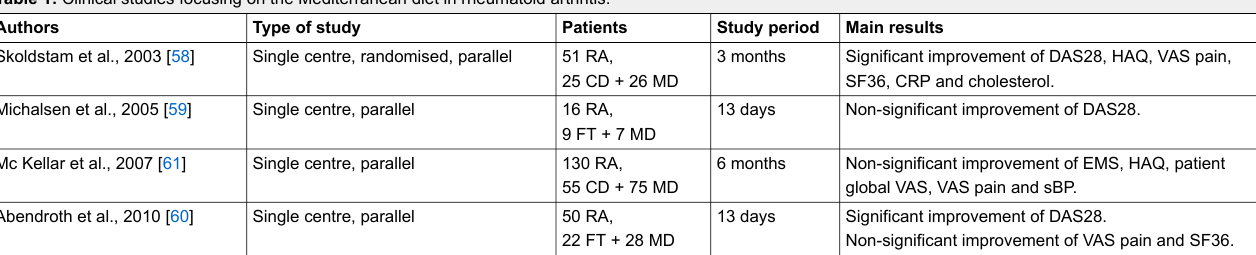
Table 1: Clinical studies focusing on the Mediterranean diet in rheumatoid